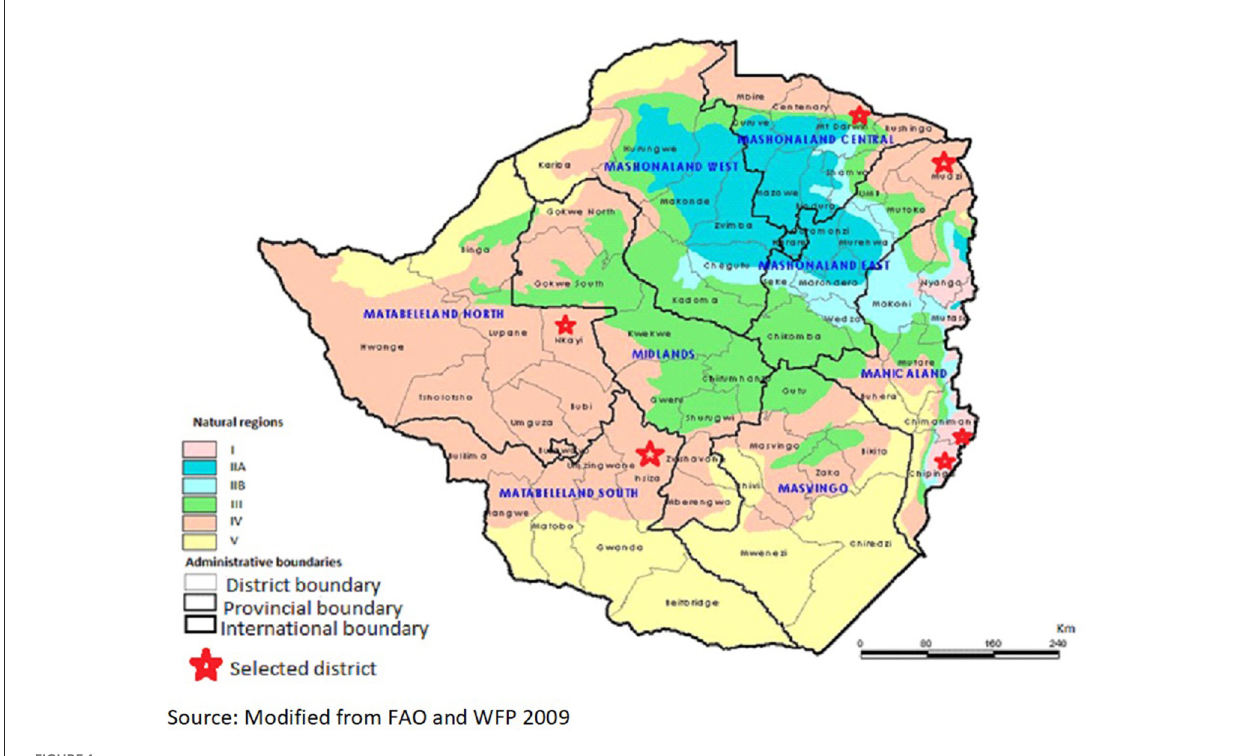
FIGURE1 Natural regions and selected districts. Source: Modified from FAO and WFP